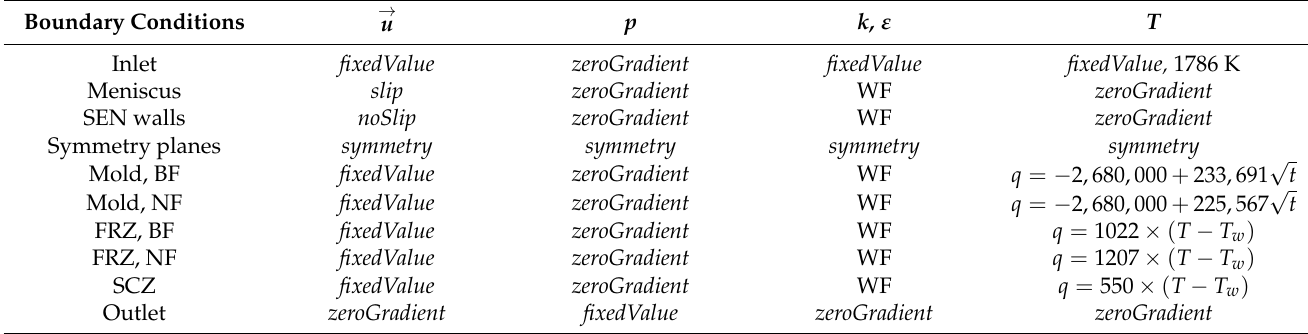
Table 2. The boundary conditions used for the flow and heat transfer